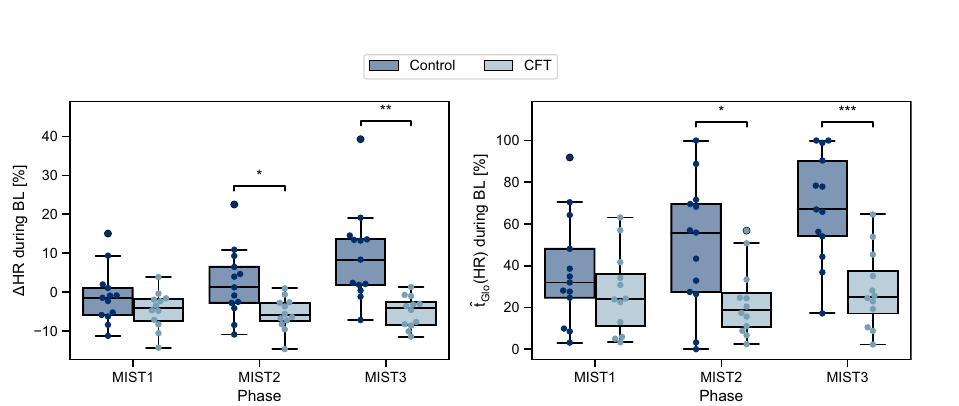
Table 3. HR(V) responses of the CFT condition to the Cold Face Test. Paired t-tests were performed between BL and RP/CFI subphases for each MIST phase separately.